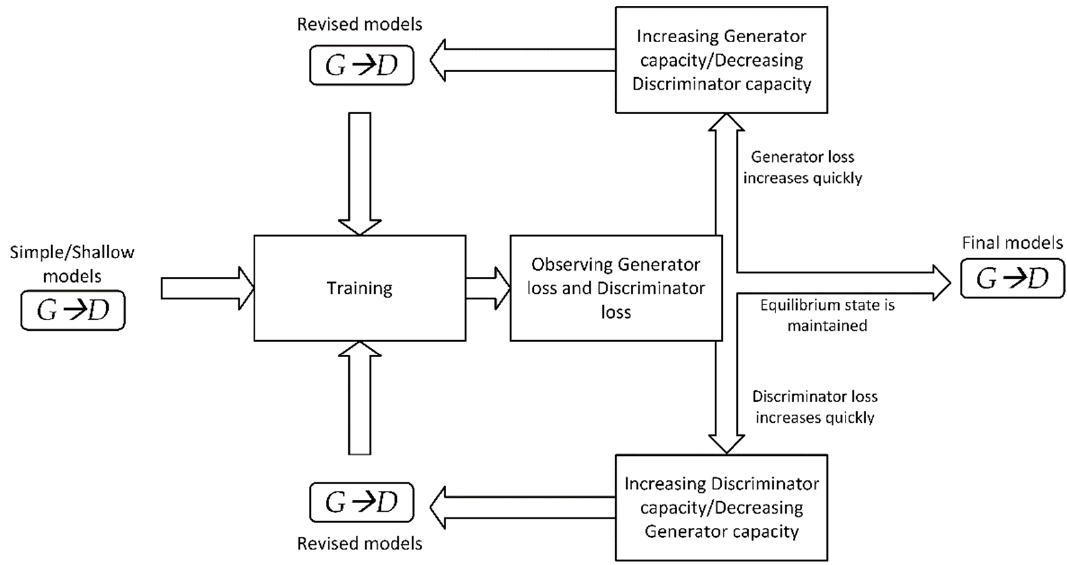
Figure 4. Unrolled GAN tuning.